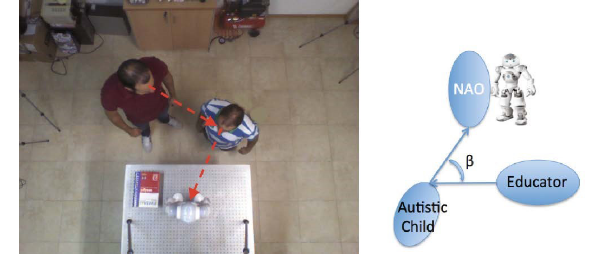
Figure 11: Juxtaposed inscriptions from [22].